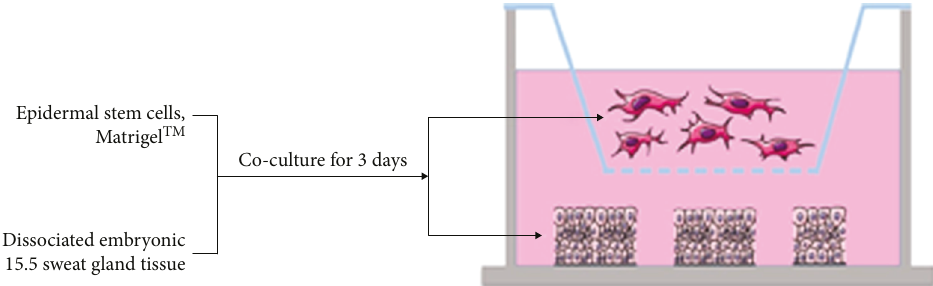
Figure 1: Schematic representation of the methods used for in vitro induction of sweat gland development by 3D culture epidermal stem cells and embryonic tissue. Embryonic tissue was incorporated into the 24-well fl at-bottom plates as the developmental environment. Epidermal stem cells and Matrigel ™ were cultured in Transwell culture